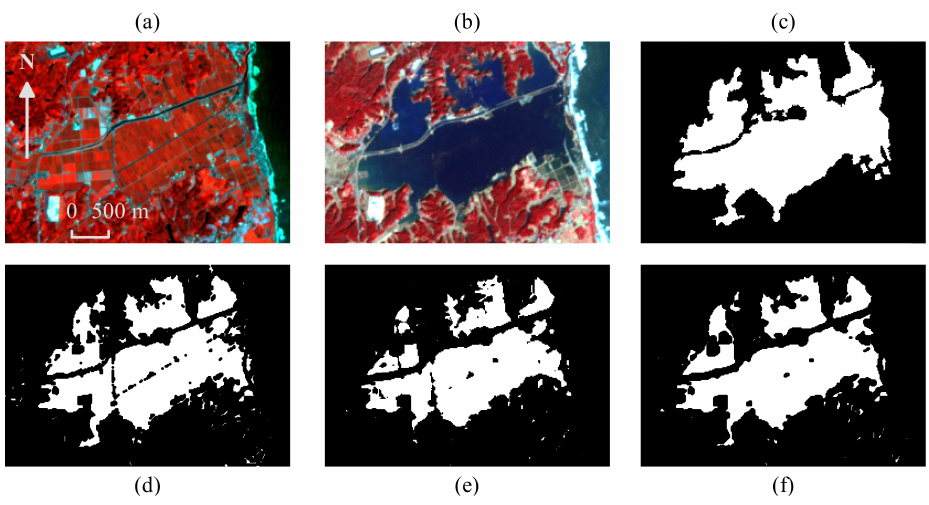
Figure 9. Clustering results, flooded area. ( a ) image taken on 7 July 2010, ( b ) image taken on 19 March 2011, ( c ) ground truth, ( d ) K-Means on subtracted image, ( e ) K-Means on concatenated encoded images, ( f ) DEC on concatenated encoded images.